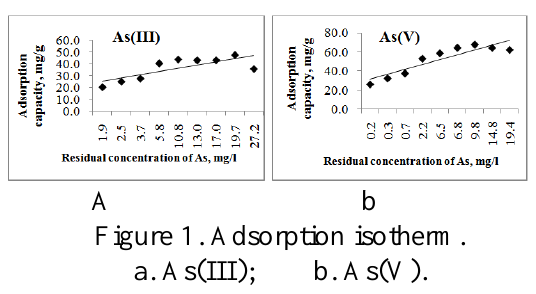
Figure 1. Adsorption isotherm.